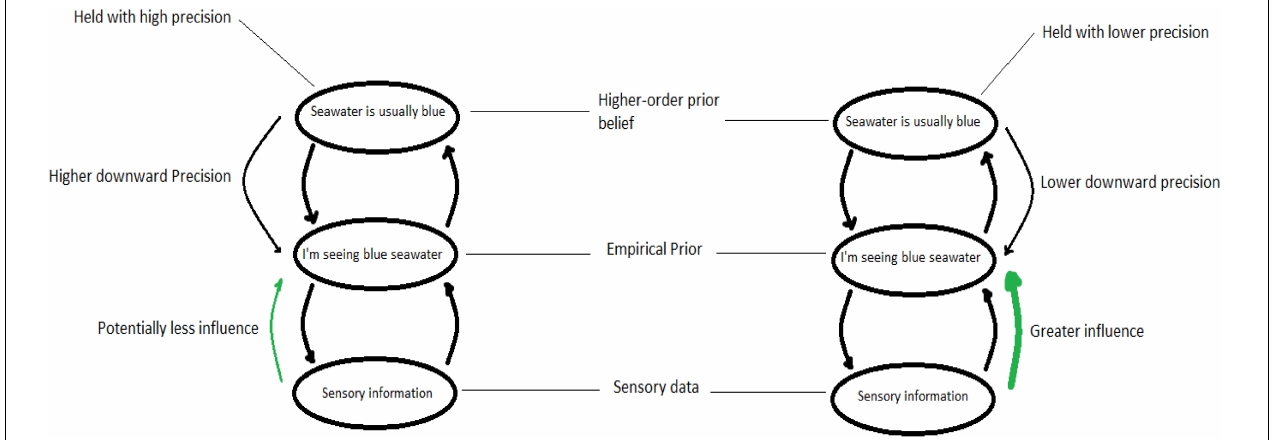
FIGURE 7 | An idealized scheme showing a hierarchical generative model at three conceptual layers, a higher-order prior belief about visual scenes, and empirical prior applied to sensory information, and a sensory layer passing data upward. Where the higher-order prior is held with high precision, the empirical prior is also held with high precision, which can potentially take action to attenuate lower-level data from influencing higher levels. In contrast, where the higher-order belief is held with lower precision, the empirical prior is also held with lower precision, allowing low-level information to have a greater influence on higher levels (and thereby on overall system